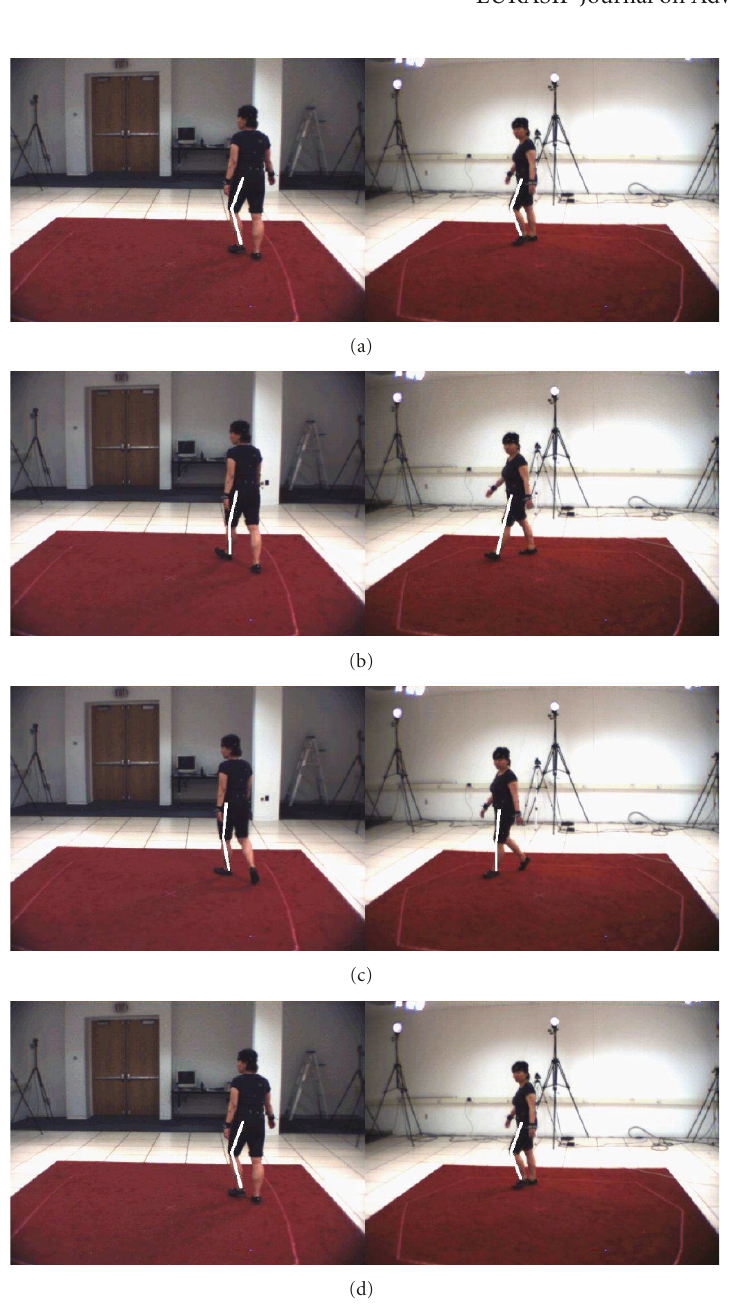
Figure 15: HumanEva walking sequence for the subject 1, applying Inverse kinematics using image-based